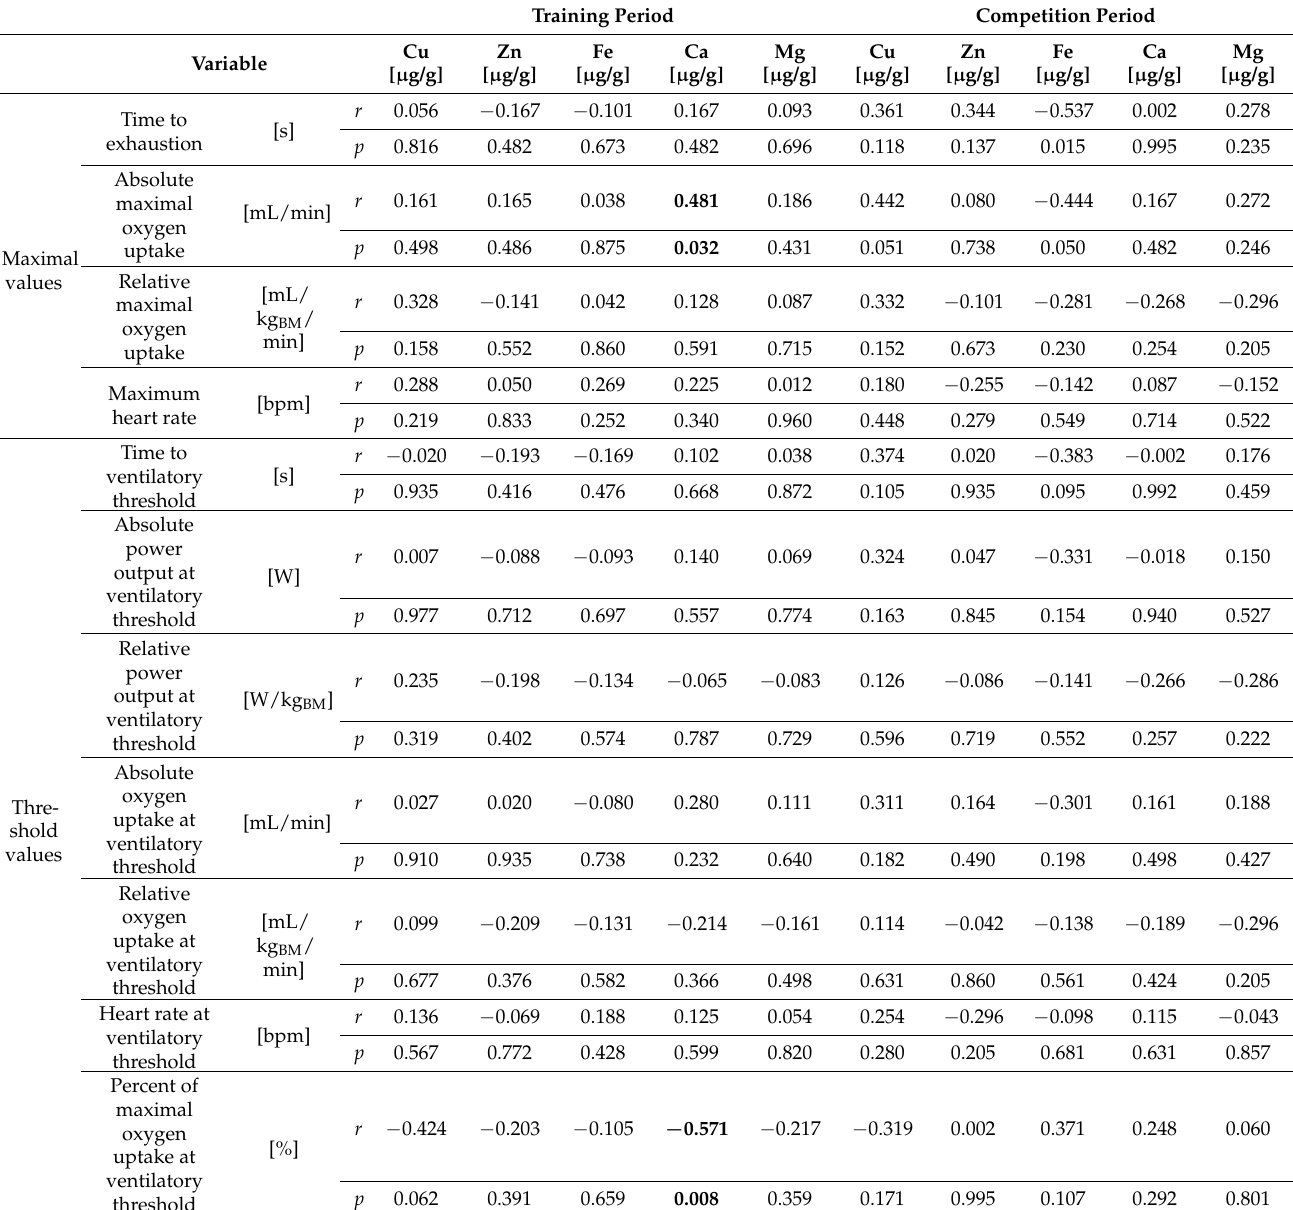
Table 8. Spearman correlation coefficient between hair mineral content and physical capacity of